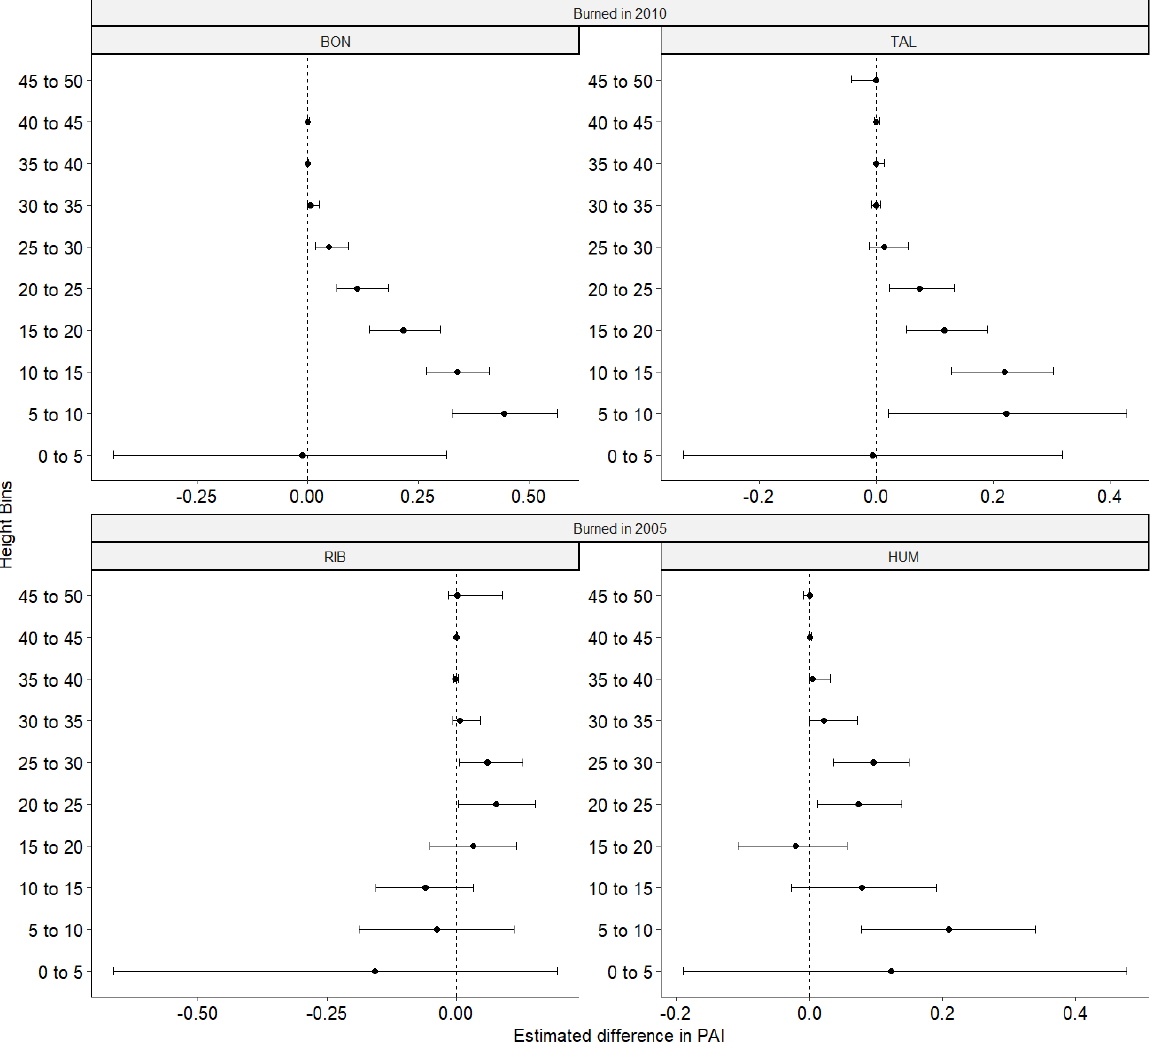
Figure 5. Estimated differences in median values of PAI by height bin across sites. Positive estimates indicate higher PAI values in unburned forest.